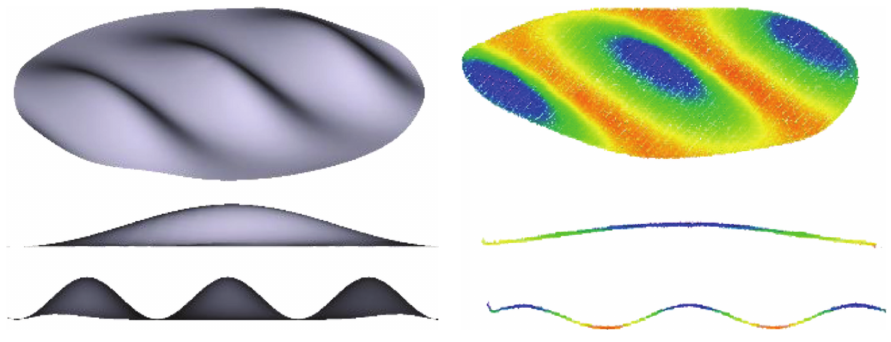
Figure 9: Simulated and reconstructed sinusoidal measuring